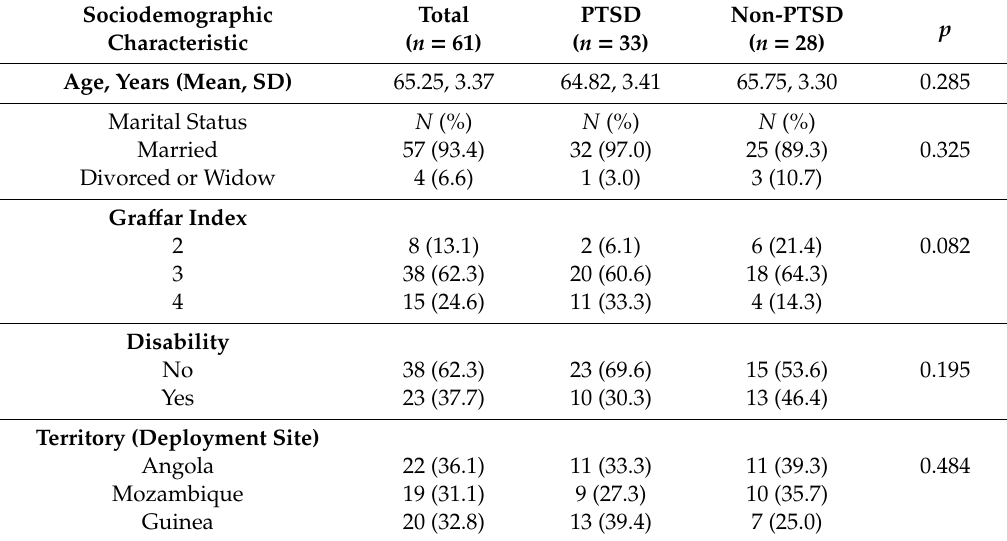
Table 1. Sociodemographic characteristics of the total sample and according to having or not having lifetime PTSD.